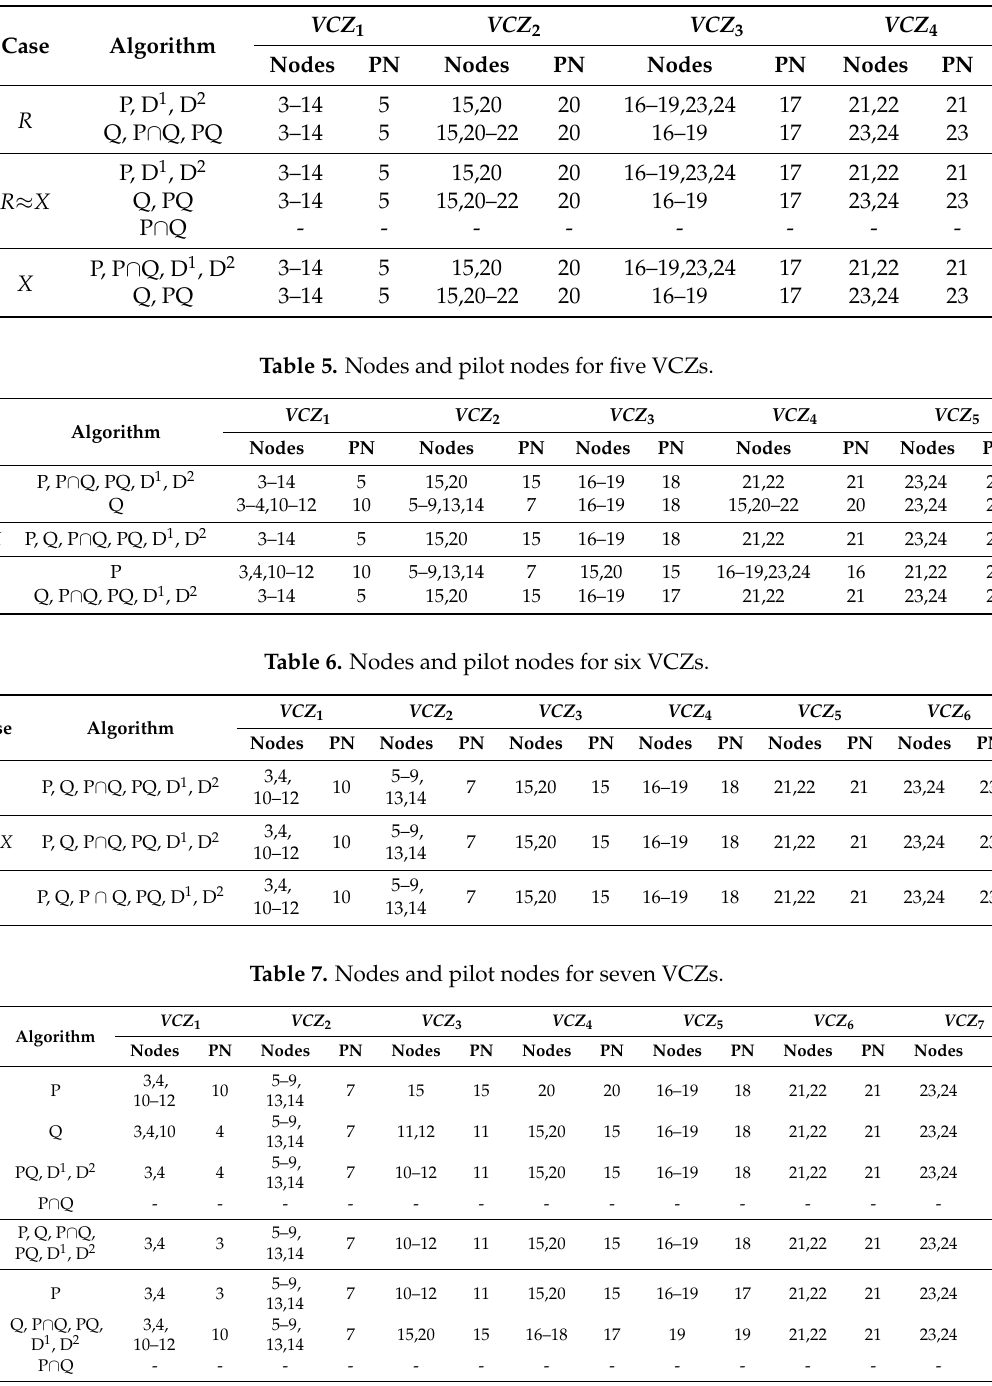
Table 4. Nodes and pilot nodes for four VCZs.